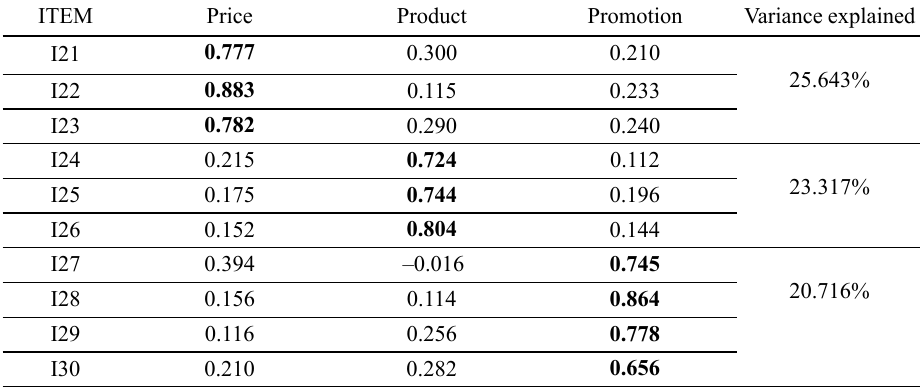
Table 4. EFA: pragmatic